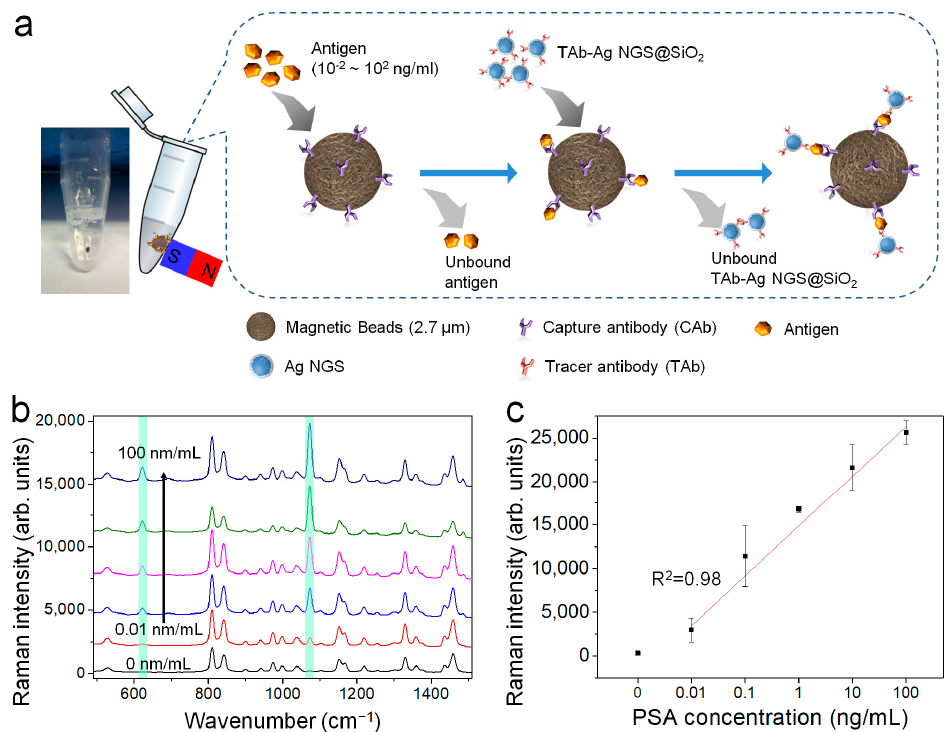
Figure 4. Quantitative detection of a prostate cancer biomarker (PSA) based on SERS spectroscopy, using a sandwich immunoassay method. ( a ) Schematic illustration of PSA detection using Ag NGS particles and magnetic beads (MBs). ( b ) SERS spectra of Ag NGS [4-FBT] @SiO 2 particles conjugate to MBs, used to detect PSA at different concentrations (0 to 100 ng/mL). ( c ) Corresponding SERS intensities at 1075 cm − 1 in ( b ) as a function of the logarithm of the PSA concentration.